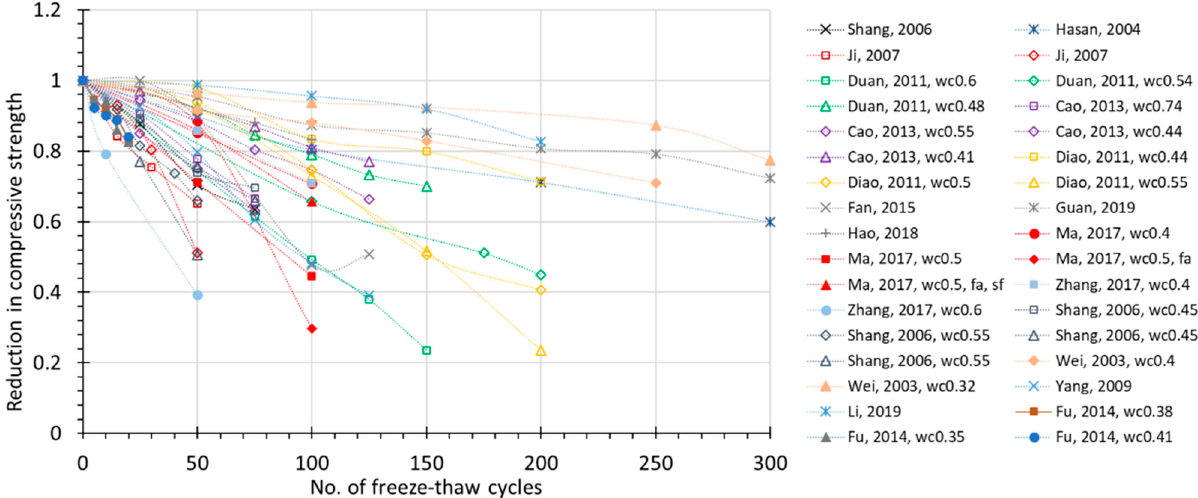
Figure 2. Relative reduction in compressive strength during FTC for non-air-entrained concrete (for the same literature, wc —water to cement ratio; fa —fly ash added; sf —silica fume added).